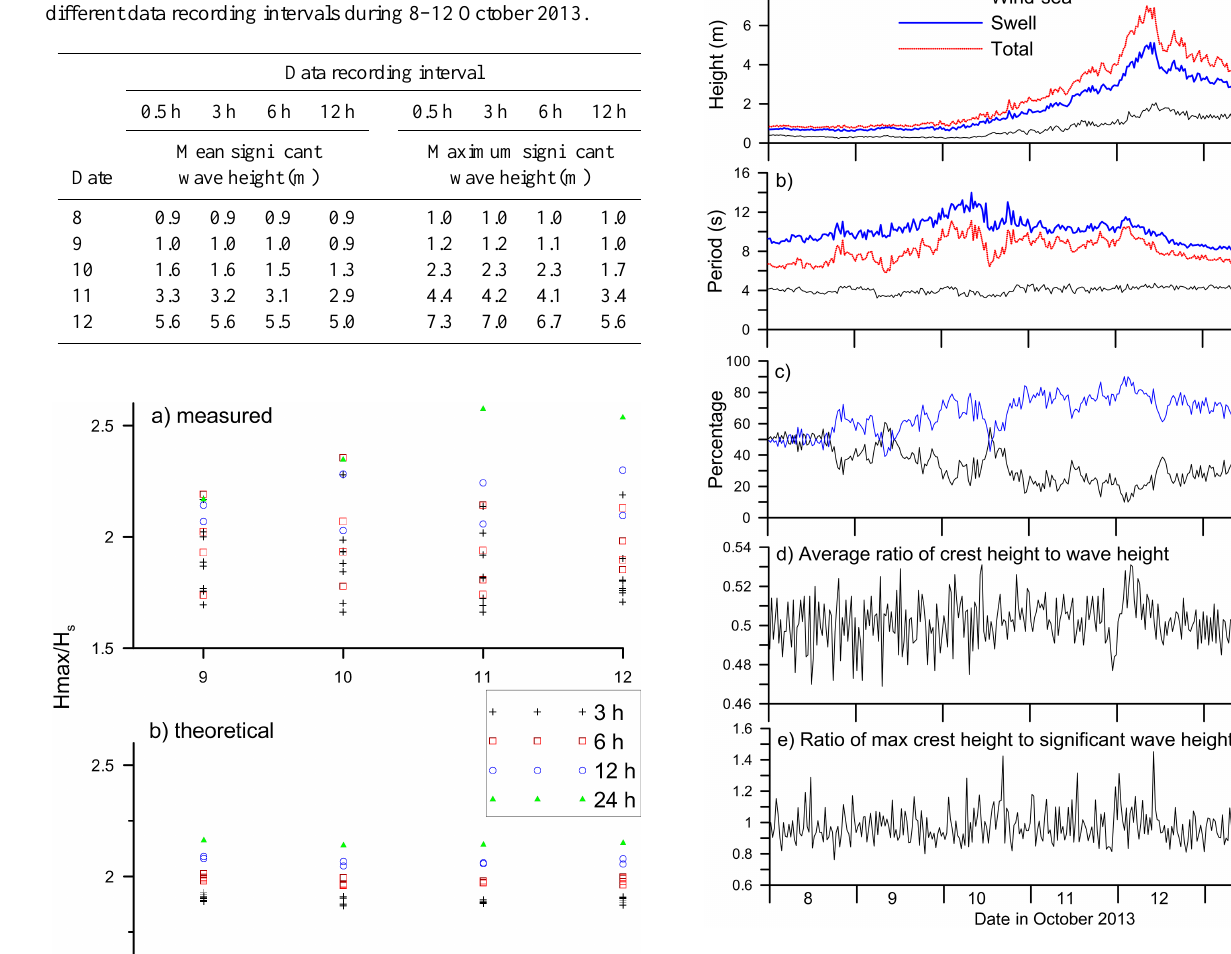
Figure 8. Variation of (a) average wave height of wind sea, swell and total, (b) average period of wind sea, swell and total, (c) per- centage of wind sea and swell, (d) average ratio of crest height to wave height and (e) ratio of the maximum crest height to significant wave height in the 30min